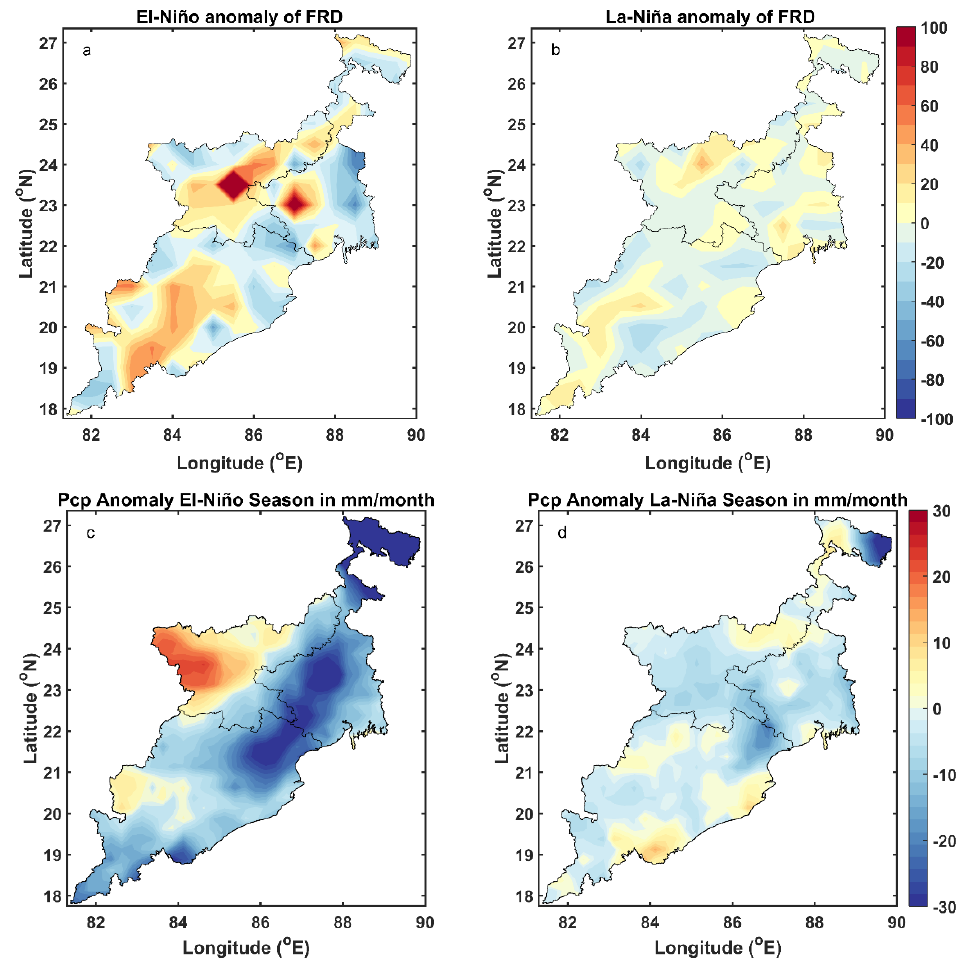
Figure 3. FRD anomalies ( a ) El-Niño, ( b ) La-Niña (upper row) and precipitation anomalies ( c ) El-Niño, ( d ) La-Niña (bottom row) during pre-monsoon season from 1998–2014.